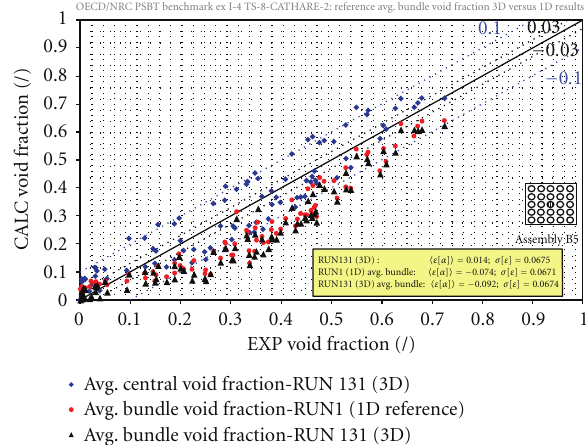
Figure 8: PSBT steady-state bundle (TS 8)—CATHARE2 3D and 1D models: central and bundle void fraction exp. versus calc., reference results.